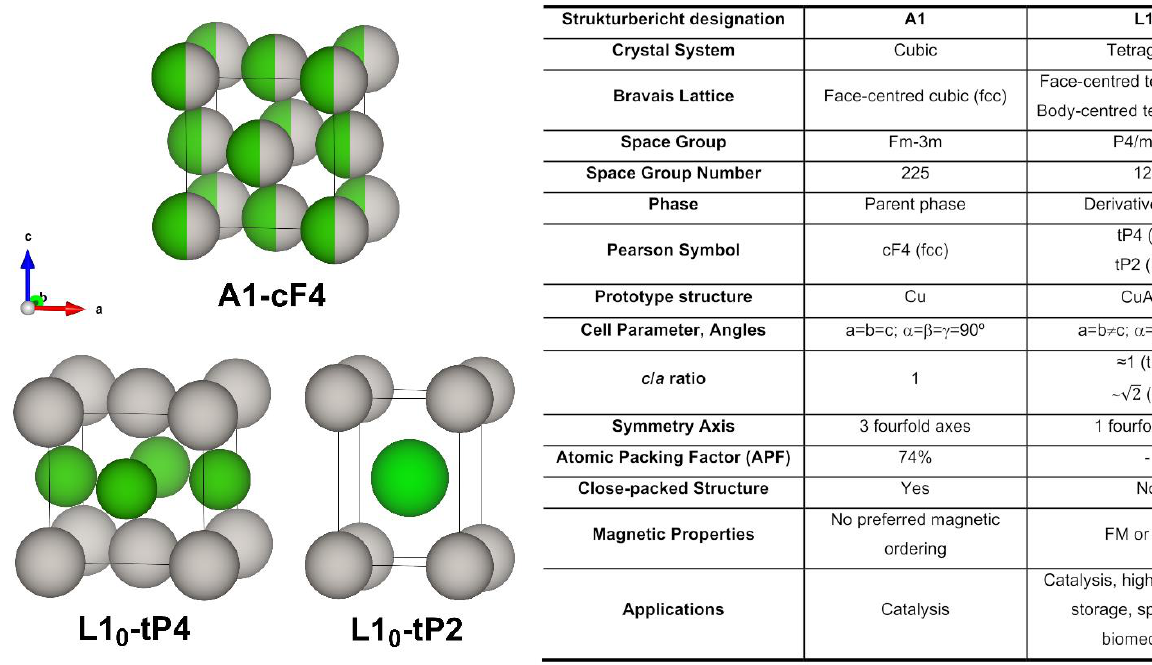
Figure 7. ( Left ): Unit cells of the parent A1 and derivative L1 0 phases ( left ). Green and gray colors indicate 3d -elements (e.g., Fe, Co and Ni) and the Pt atoms, respectively. ( Right ): The table shows main crystallographic and general information on the two